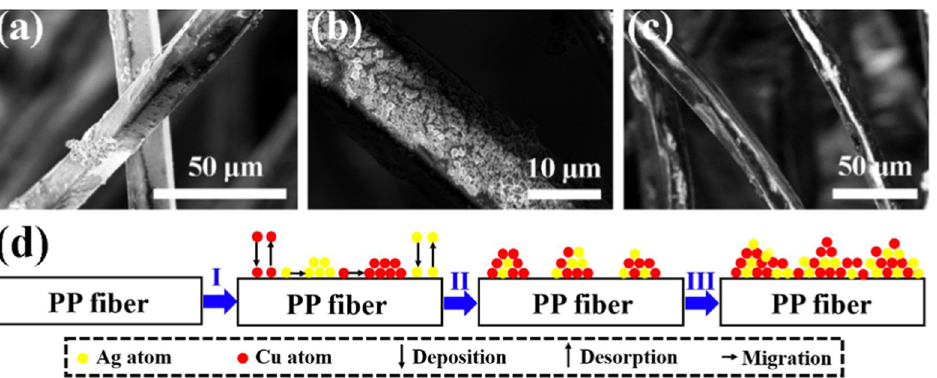
Figure 2: ( a – c ) SEM images of Cu/Ag - deposited PP fi bers at di ff erent magnetron sputtering stages and ( d ) the growth process of Cu/Ag thin fi lm deposited on PP fi